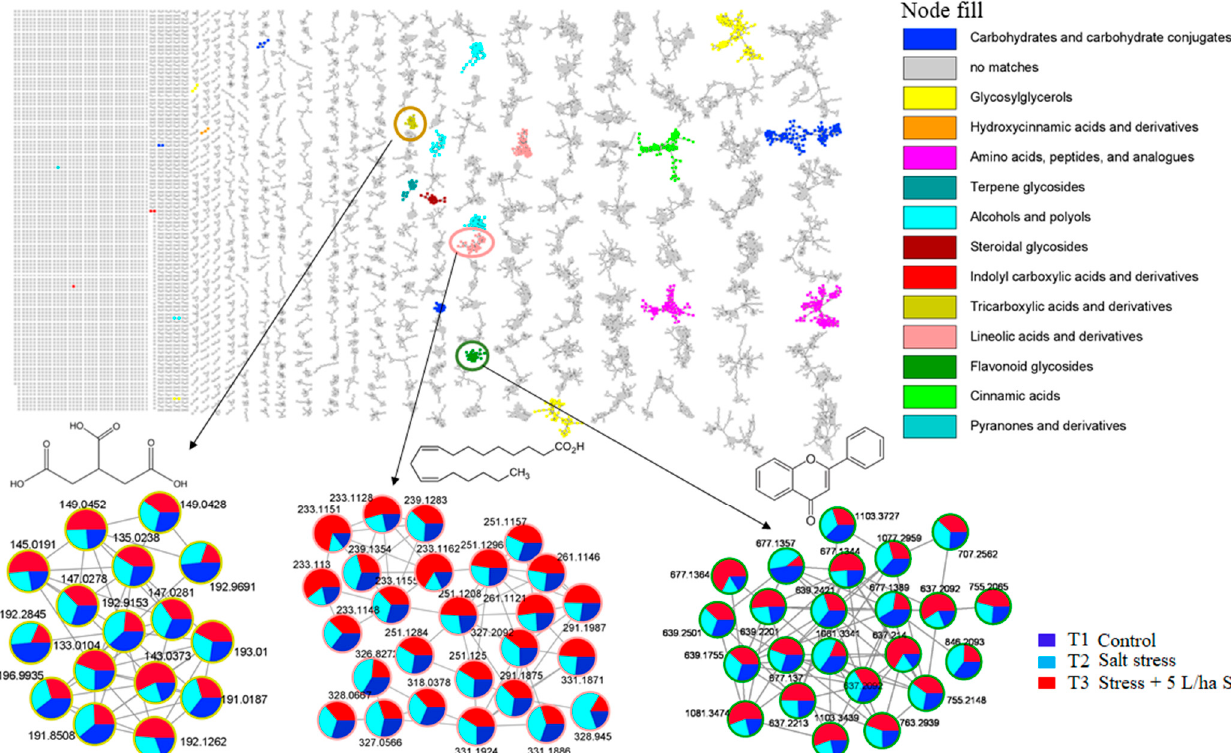
Figure 1. Molecular network of all detected ions using MS/MS data in the negative mode. Nodes from the selected clusters (tricarboxylic acids, linoleic acids, and flavonoids) are labelled with parent masses and displayed as pie charts representing distribution of ion intensities in the non-stressed controls (T1: dark blue), salt stressed (T2: light blue) and Si treated salt stressed samples (T3: red).